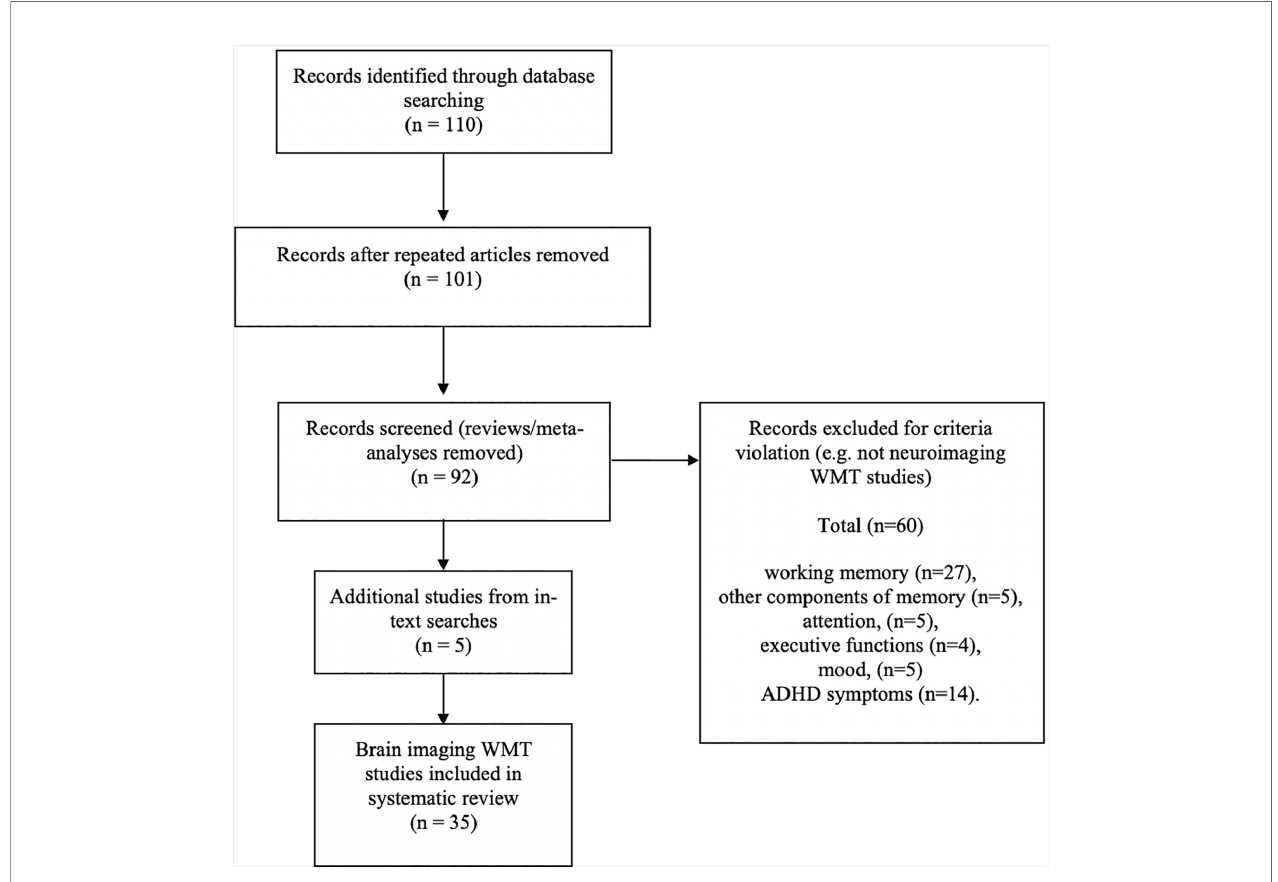
FIGURE 1 | CONSORT